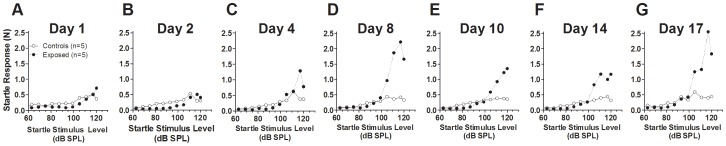
Comparison of the ASR growth curves from control (n = 5) and exposed animals (n = 6) at each of the 7 post-exposure times indicated at the top of each graph (panels A–G).The data shows decrements in ASR in exposed animals during the first two days post-exposure, but by the fourth day, there is a suggestion of enhanced ASR at the highest startle stimulus levels. This enhancement was better established by the 8th day at all stimulus levels above 100 dB SPL and continued through the remainder of the 2 weeks of measurements, although the degree of enhancement varied over time.